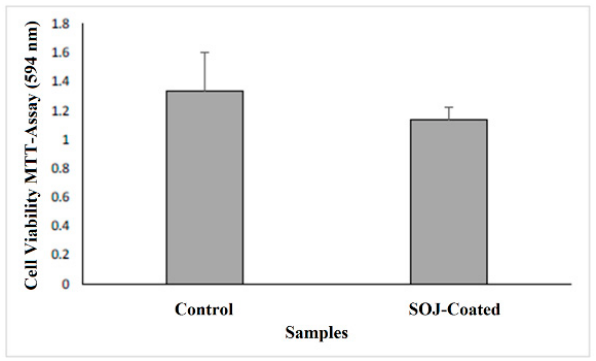
Figure 5. Comparison of cell viability (3T3 Mouse Embryonic Fibroblast) between PHB fibers (control) and SOJ-coated PHB fibers via MTT assay following 7 days of incubation, n = 3 experiments. (* p - value < 0.05)